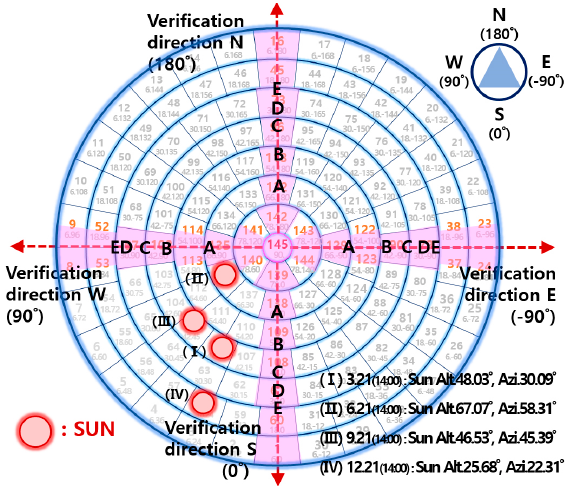
Figure 9. Verification points for the sky patches [61].